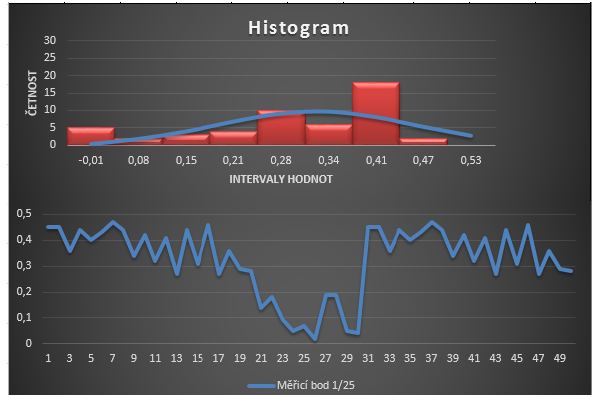
Figure 4: Graphic part of the form